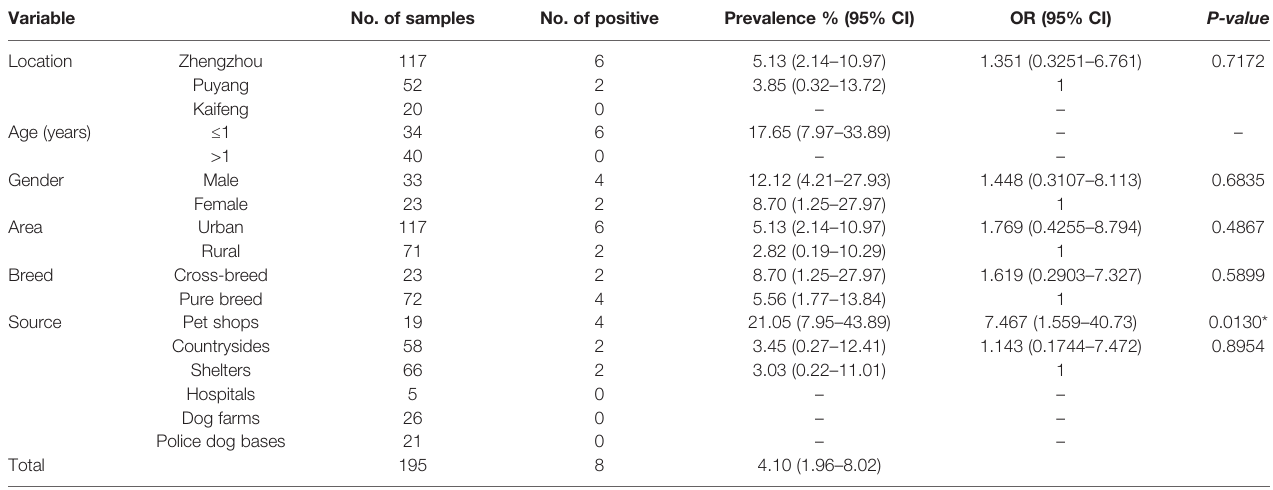
TABLE 2 | Prevalence and risk factors of Toxoplasma gondii in dog feces tested by PCR. Variable No. of